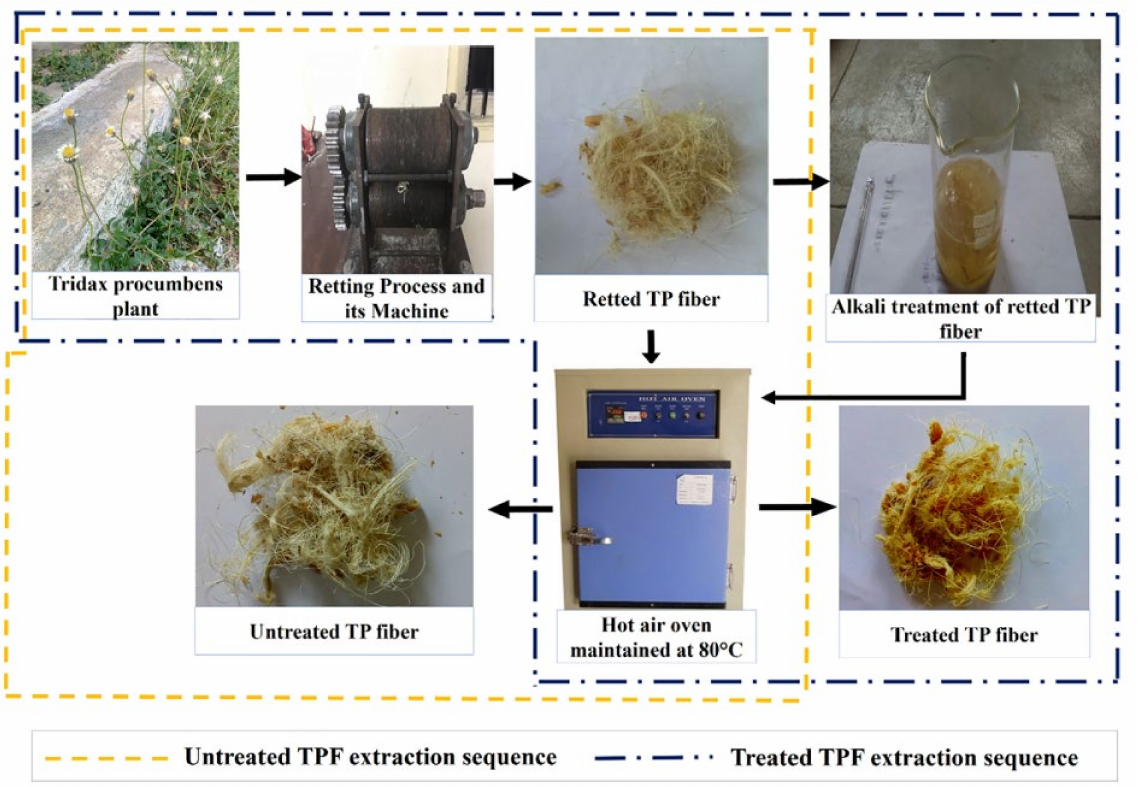
Figure 6. Pictorial representation of alkali treatment of Tridax procumbens plant. Reprinted with permission from Ref. [66]. License Number: